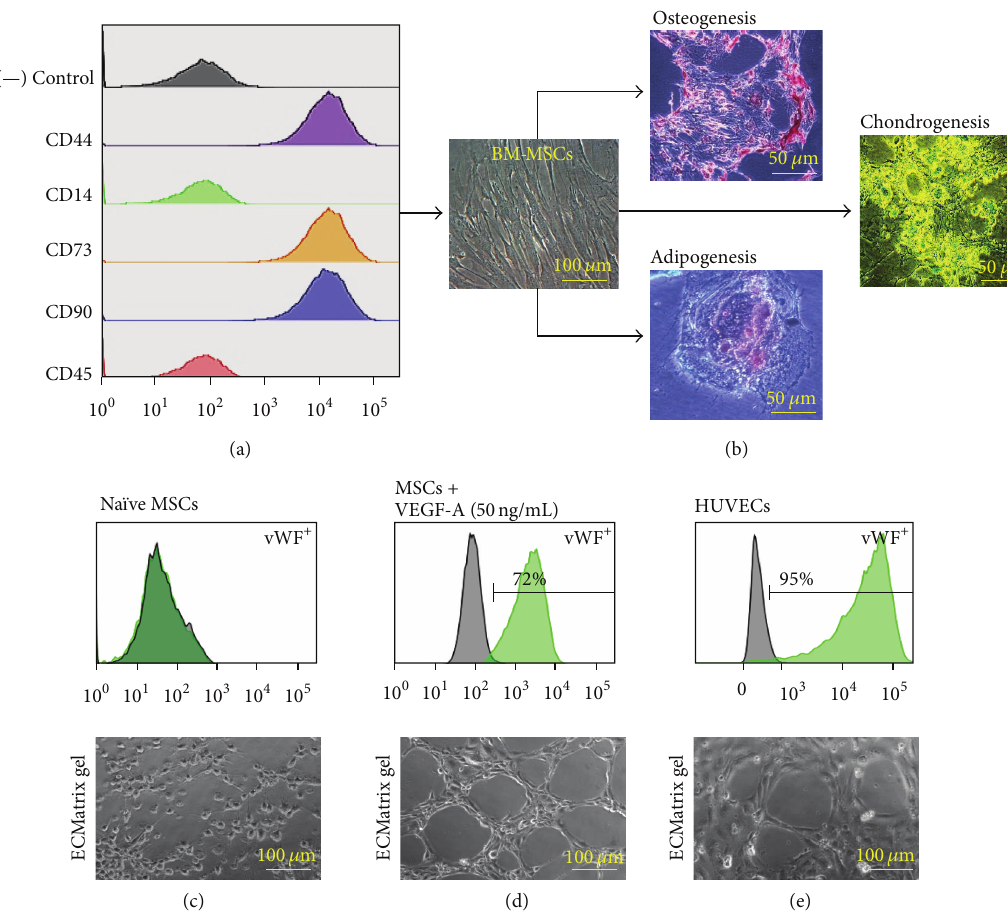
Figure 1: Characterization of BM-MSCs: detailed FACS characterization revealed that MSCs at P3 to P5 stained negatively for CD14 and CD45 but expressed surface markers that are indicative of MSC lineage, including CD44, CD73, and CD90 (a). Isolated MSCs also exhibited fibroblastoid-like morphology (b). Na¨ıve BM-MSCs demonstrated the capacity to differentiate in osteogenic, chondrogenic, and adipogenic lineages. Alizarin red showed staining of calcium deposits in MSCs differentiated into the osteogenic lineage. Alcian/Safranin O blue showed staining of peptidoglycans characteristic of differentiation into the chondrogenic lineage. Oil Red O showed staining of the lipids and triglycerides, indicating differentiation into the adipogenic lineage. Each image shown is representative of independent experiments performed with BM-MSC cultures derived from separate microswine ( 𝑛 = 3 ). FACS analysis performed for EC markers on na¨ıve MSCs (c), MSCs treated with VEGF-A (d), and HUVECs (e). Each grid shown is representative of independent experiments performed with cultures derived from bone marrow of separate microswine ( 𝑛 =